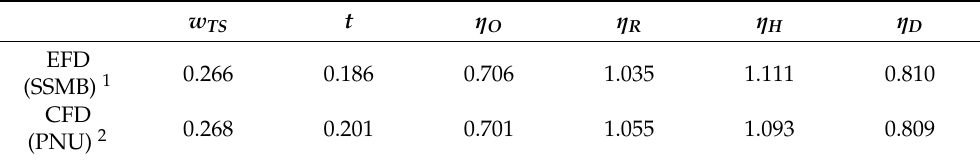
Table 4. Comparison of self-propulsion results between experimental fluid dynamics (EFD) and computational fluid dynamics (CFD) of the 1800 TEU container